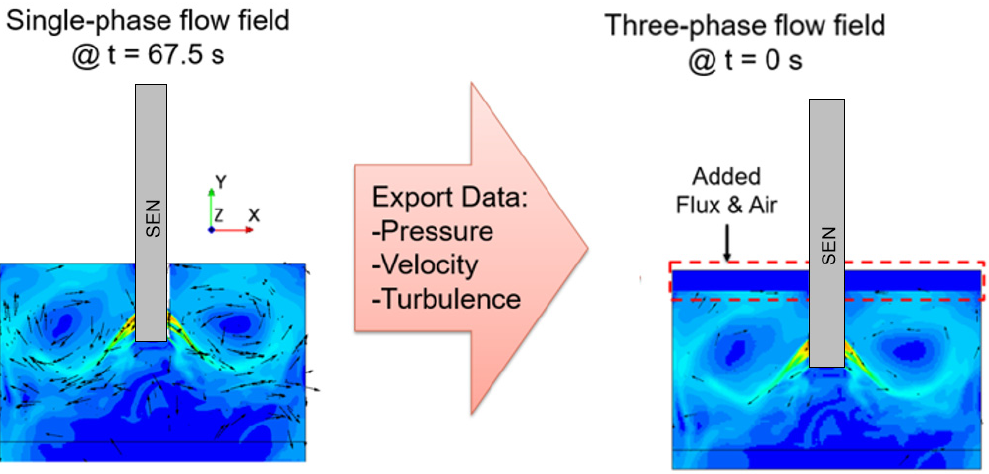
Figure 4. One ‐ phase and three ‐ phase simulation setup.